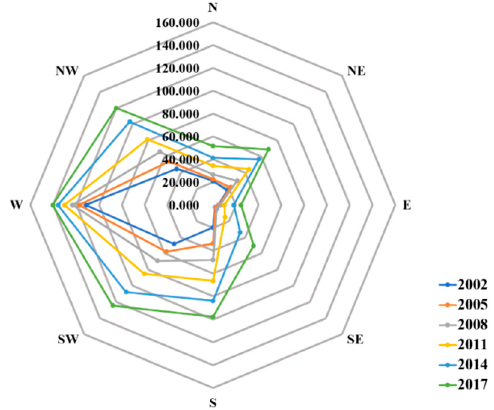
Figure 4. The variations of impervious surface area in eight sub-regions from 2002 to 2017. Table 5. Statistics of impervious surface sprawl in eight sub-regions from 2002 to 2017. Sub-regions